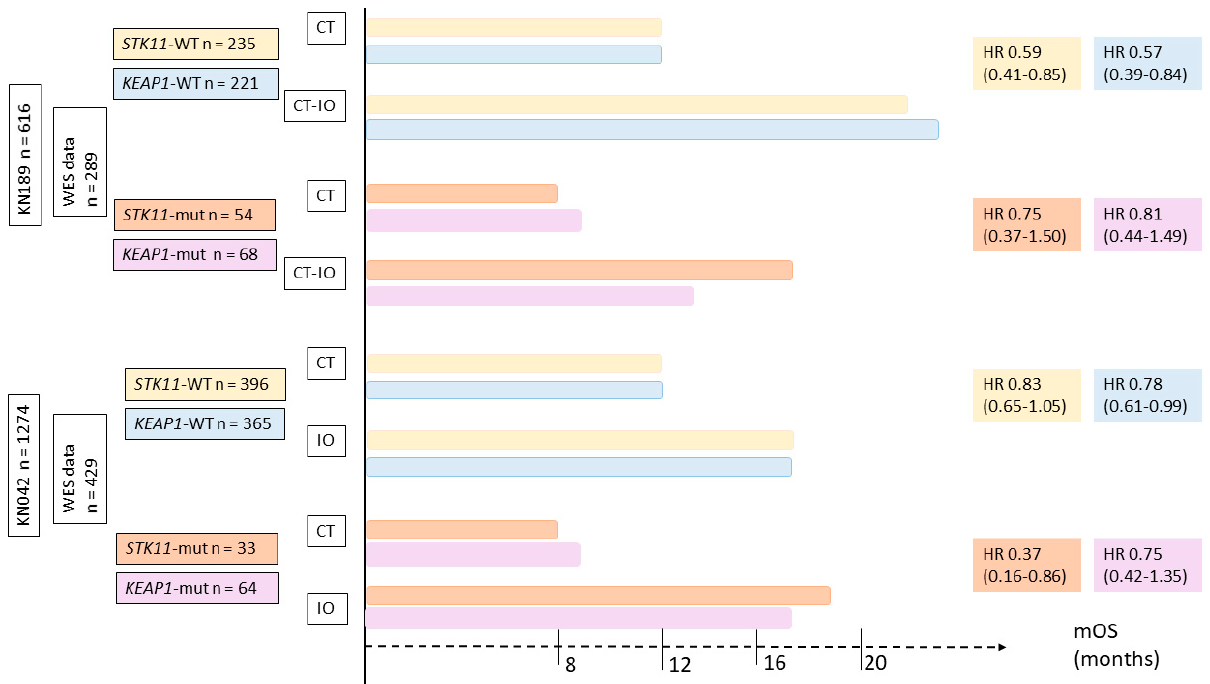
Figure 4. Impact of STK11 or KEAP1 status on immune resistance during first-line therapy based on two phase III trials, evaluated chemotherapy versus immunotherapy (KEYNOTE 042) or versus chemo-immunotherapy (KEYNOTE 189). CT = chemotherapy, IO = immunotherapy.